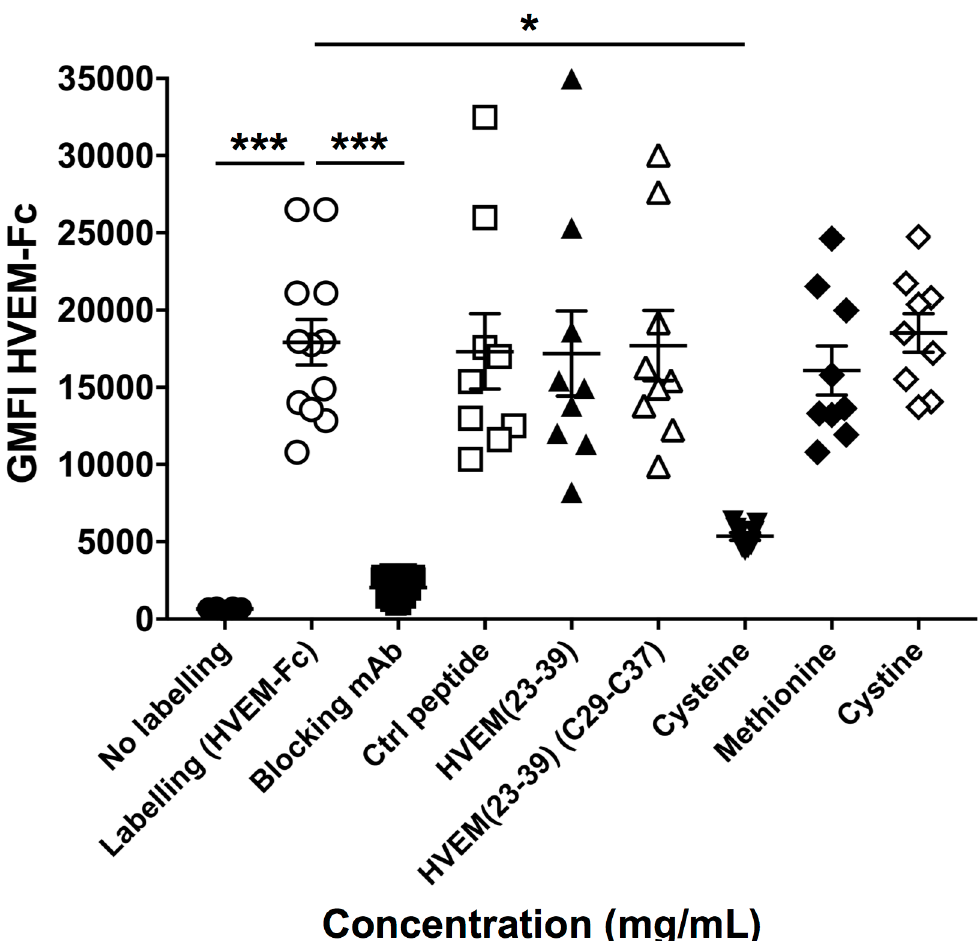
Fig 7. Blocking capacity of HVEM(23–39) fragment and free amino acids in a cellular assay. 293T cells expressinghumanBTLA were incubatedwith peptidesor free amino acids (5mg/mL) prior labelingwith rhHVEM-Fc and AF647-conjugated anti-human IgG antibody(at least two experiments in triplicate). The graph shows the Geometric Fluorescence Intensity (GMFI). * : p < 0.05 and *** : p < 0.001 followingnon-parametric One- way ANOVA and